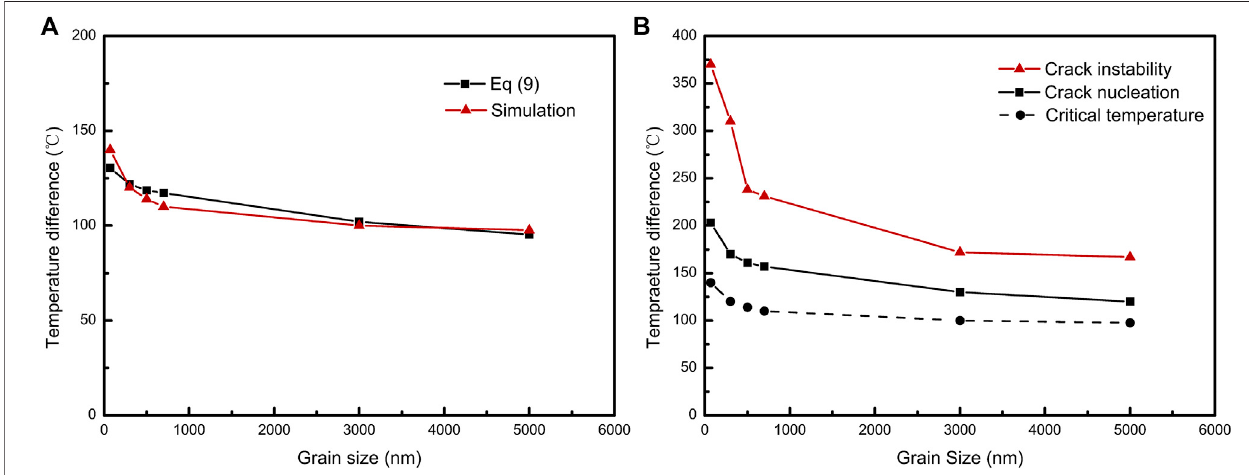
FIGURE7|(A) Rcalculatedfrom Eq.9 andthecriticalstresstemperaturedifferenceobtainedfromsimulationwithdifferentgrainsizes. (B) Temperaturedifference of critical stress, crack nucleation, and crack instability with different grain sizes.